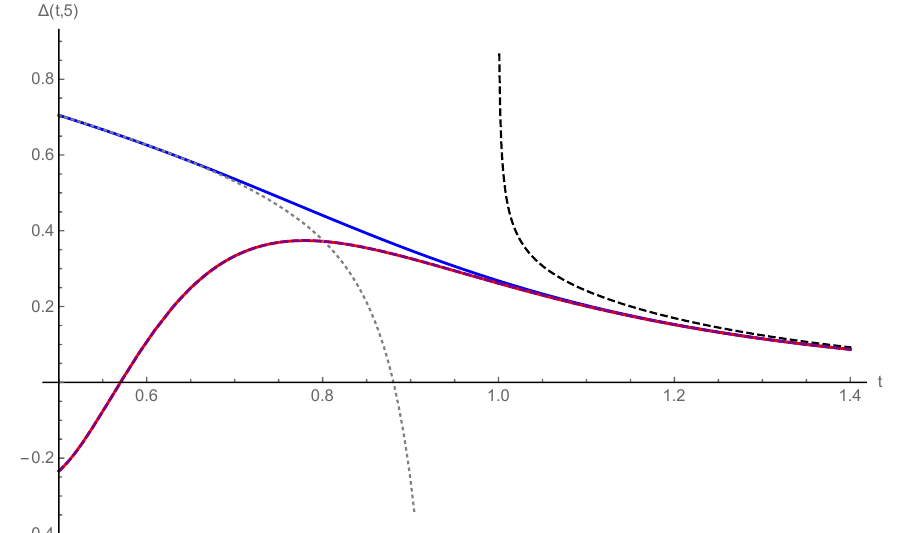
Figure 13 . Plot of (cid:1)( t; N ) for N = 5, as a function of the ’t Hooft coupling t , showing the unphysical divergence of the usual large N expansion approximations at the critical value of t = 1. The solid blue curve is the exact result. The full strong-coupling one-instanton approximation, (cid:1) ( t; N ) = J N ( N=t ), and its uniform large N approximation, are shown in the blue and red dashed (1) curves, which are indistinguishable. Note that the strong-coupling one instanton approximation does not diverge at the critical point t = 1, and is very accurate in the vicinity of the GWW transition point at t =